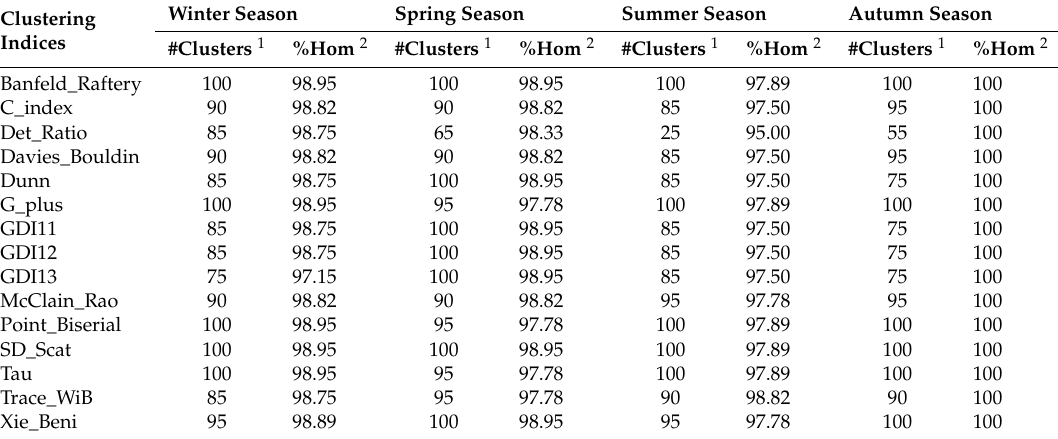
Figure 12. Performance of CVI in GL-SL region—Autumn season. The numbers indicate the percentage homogeneity for the number of clusters in the x-axis and index value on the y-axis. The scientific notation ‘E’ used in labels of y-axis represent ‘10 to the power of’. Table 3. Number of clusters and their corresponding percentage homogeneity values for the selected CVI for each season in GL-SL